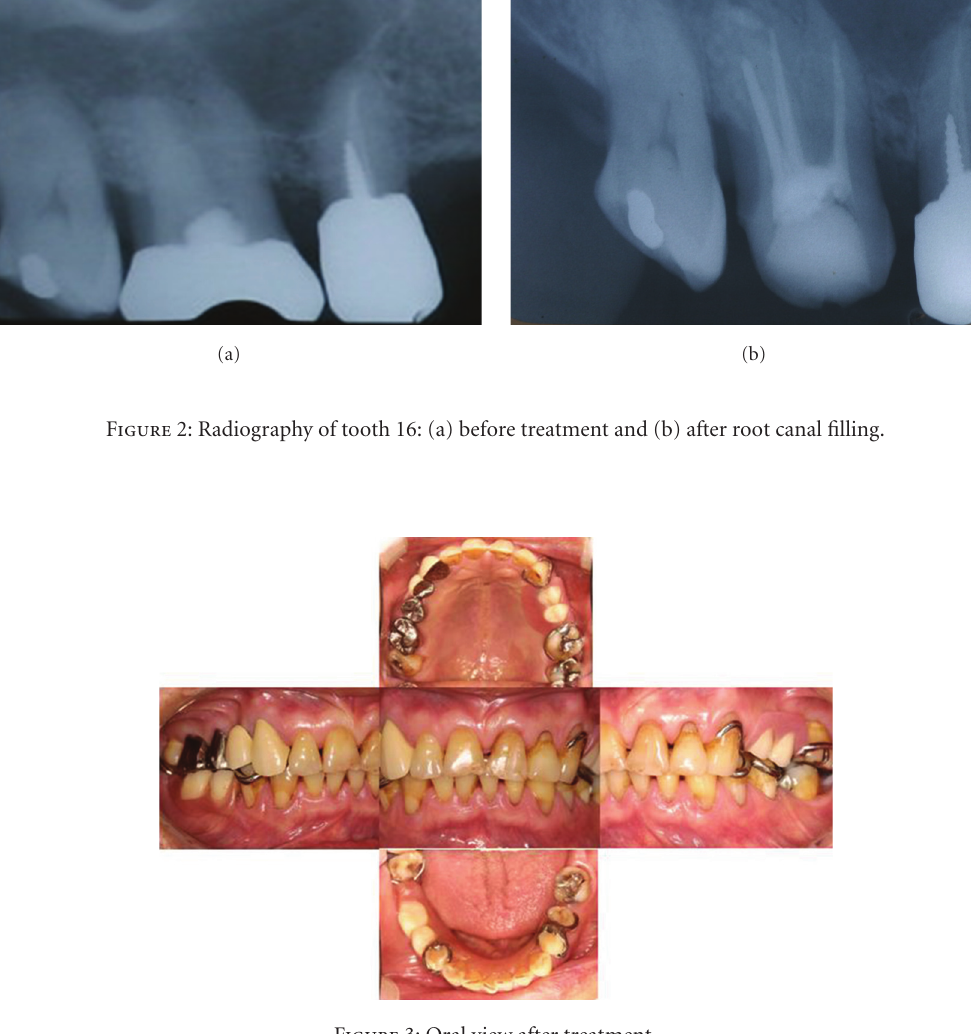
Figure 3: Oral view after